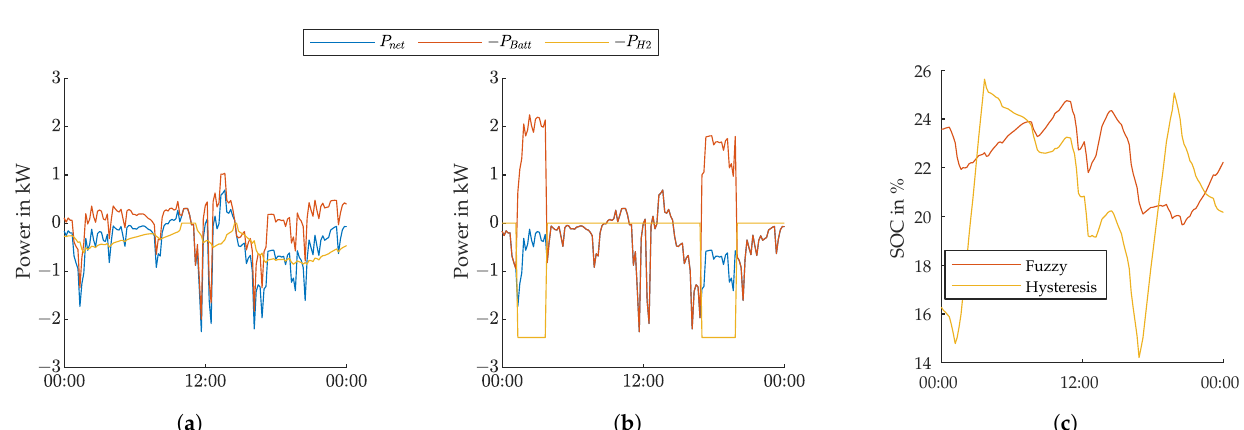
Figure 12. Timeseries winter day. ( a ) Expert tuned fuzzy logic controller. ( b ) Three-point hysteresis controller. ( c ) Battery SOC